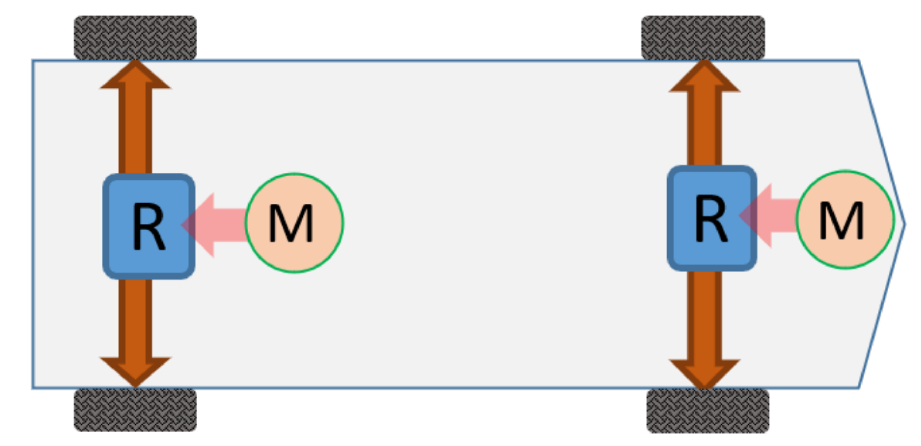
Figure 5. All-wheel